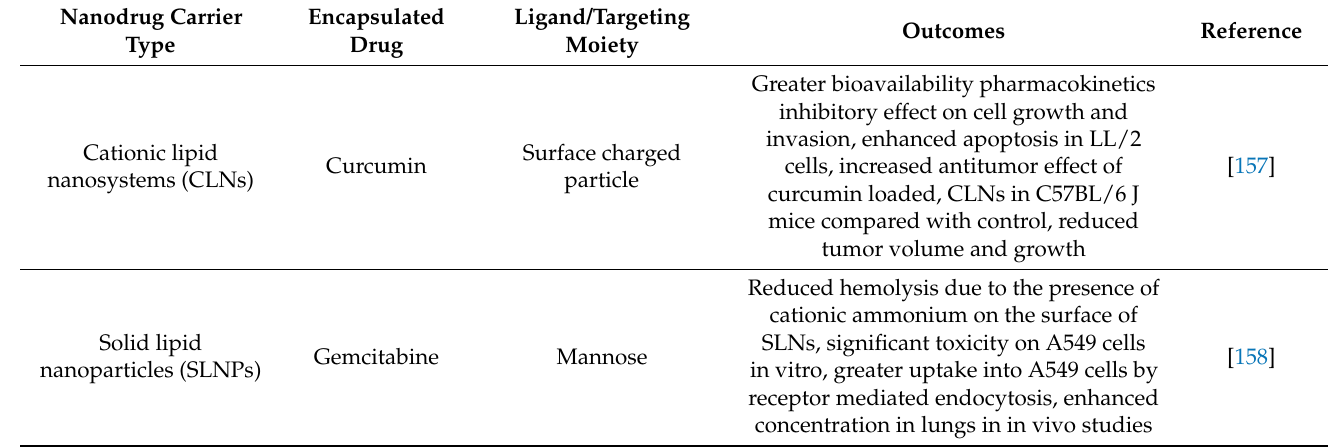
Table 2. Summary of the recent studies on comparison between surface-modified and unmodified nanoparticles in lung cancer